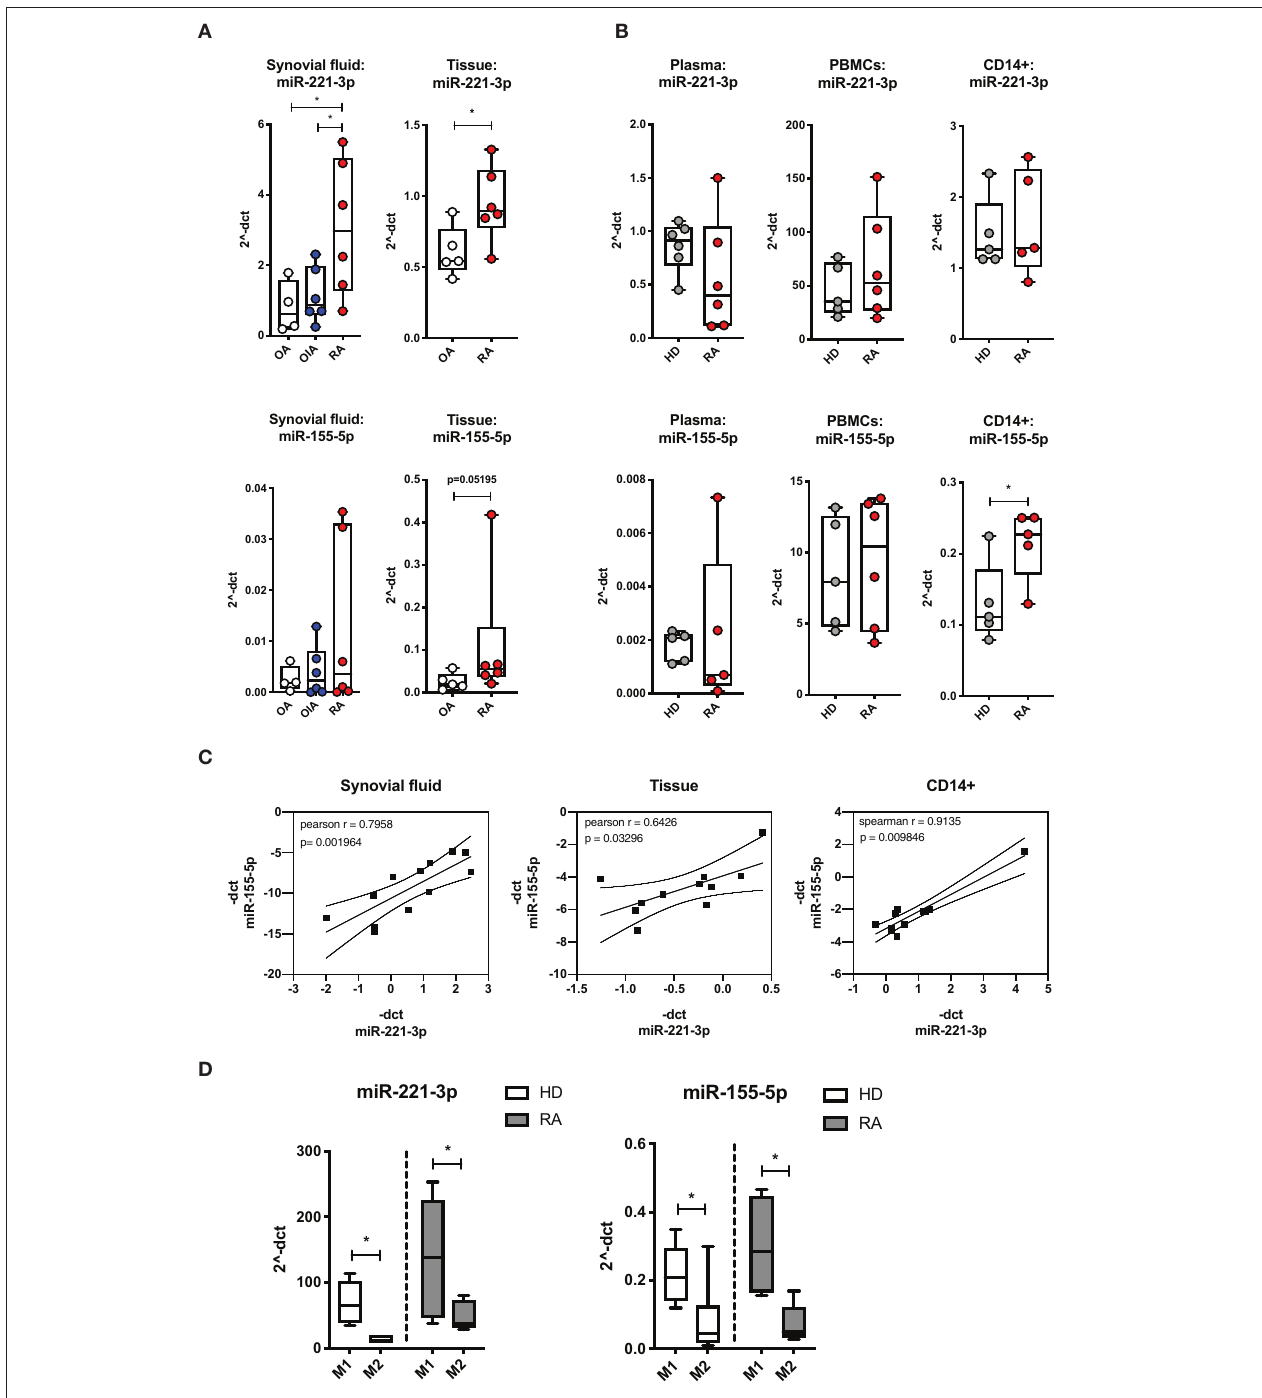
FIGURE 1 | Comparison of miR-221-3 p and miR-155-5 p expression levels in clinical samples from healthy donors (HD), patients with rheumatoid arthritis (RA), other inflammatory arthritis (OIA) and osteoarthritis (OA). (A) miR expression levels in the synovial fluid of RA patients were compared to patients with OIA (psoriatic- and spondyloarthritis) and OA, and miR expression in synovial tissue was compared between biopsy samples from RA and OA patients. (B) miR expression levels were measured in plasma, PBMCs and isolated CD14 + cells from the peripheral blood of RA patients and HD. miR expression was measured by qRT-PCR and normalized to control miRs (miR-16-5 p , miR-103-5 p , miR-15b-5 p, or spike-in cel-miR-39) and expressed as 2 − 1 CT by boxplot with min/max whiskers. N = 4–6, * p < 0.05. (C) − 1 CT level of miR-221-3 p was plotted against miR-155-5 p level from synovial fluid, tissue and CD14 + cells from blood and the Pearson or Spearman correlation and p -values were computed. Data are plotted with regression coefficients (solid line) and 95% confidence intervals (broken lines). (D) Expression levels of tested miRs were compared in M1- and M2-macrophages generated from CD14 + cells of PBMCs from HD or RA patients and presented as 2 − 1 CT by boxplot with min/max whiskers. N = 3–6, * p <